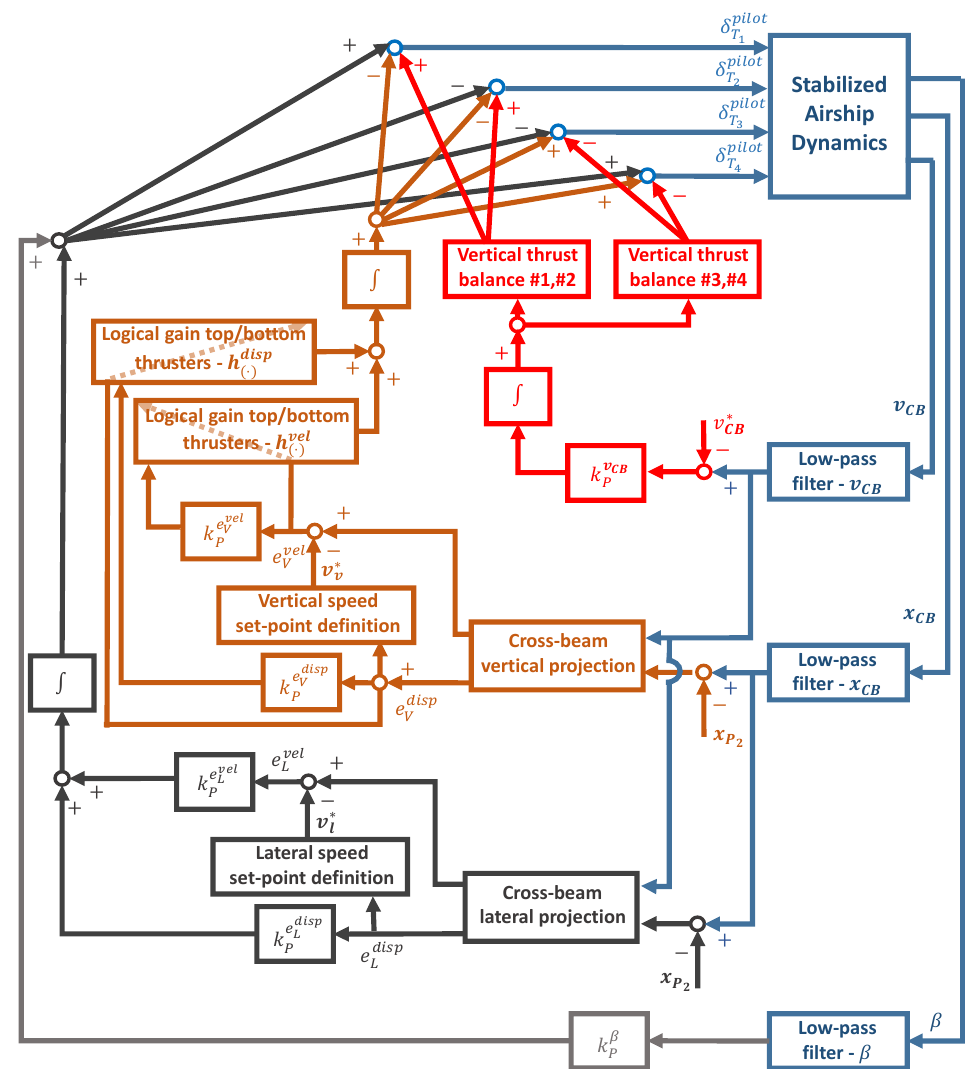
Figure 8. Proposed guidance control for the four-thrusters concept. Same color codes as for Figure